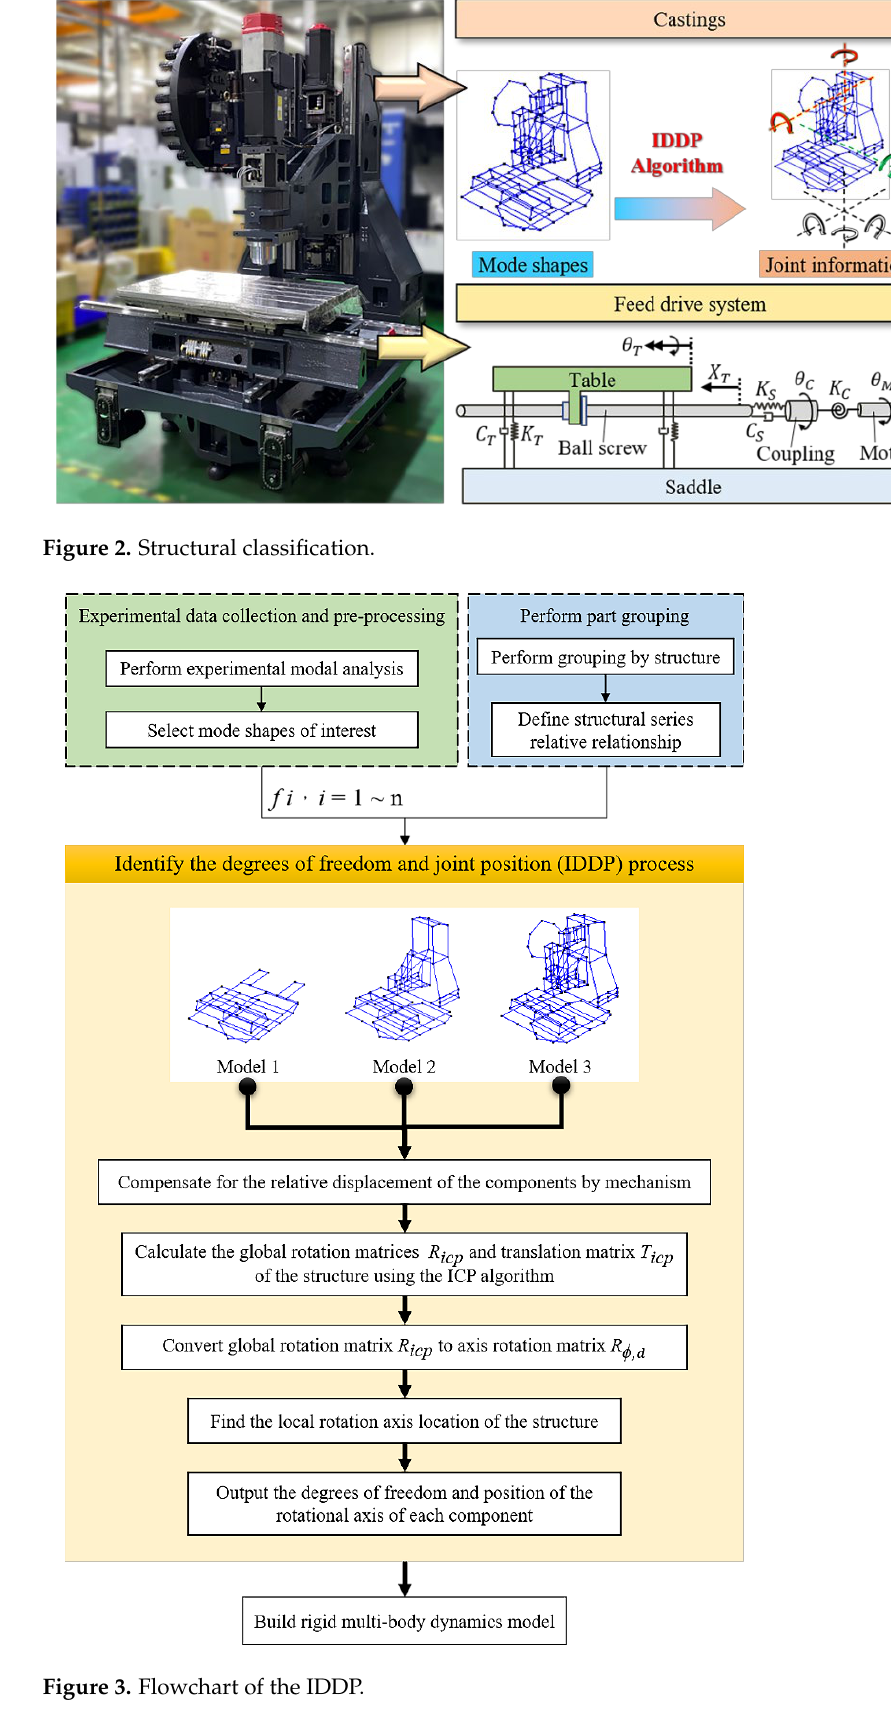
Figure 3. Flowchart of the IDDP.